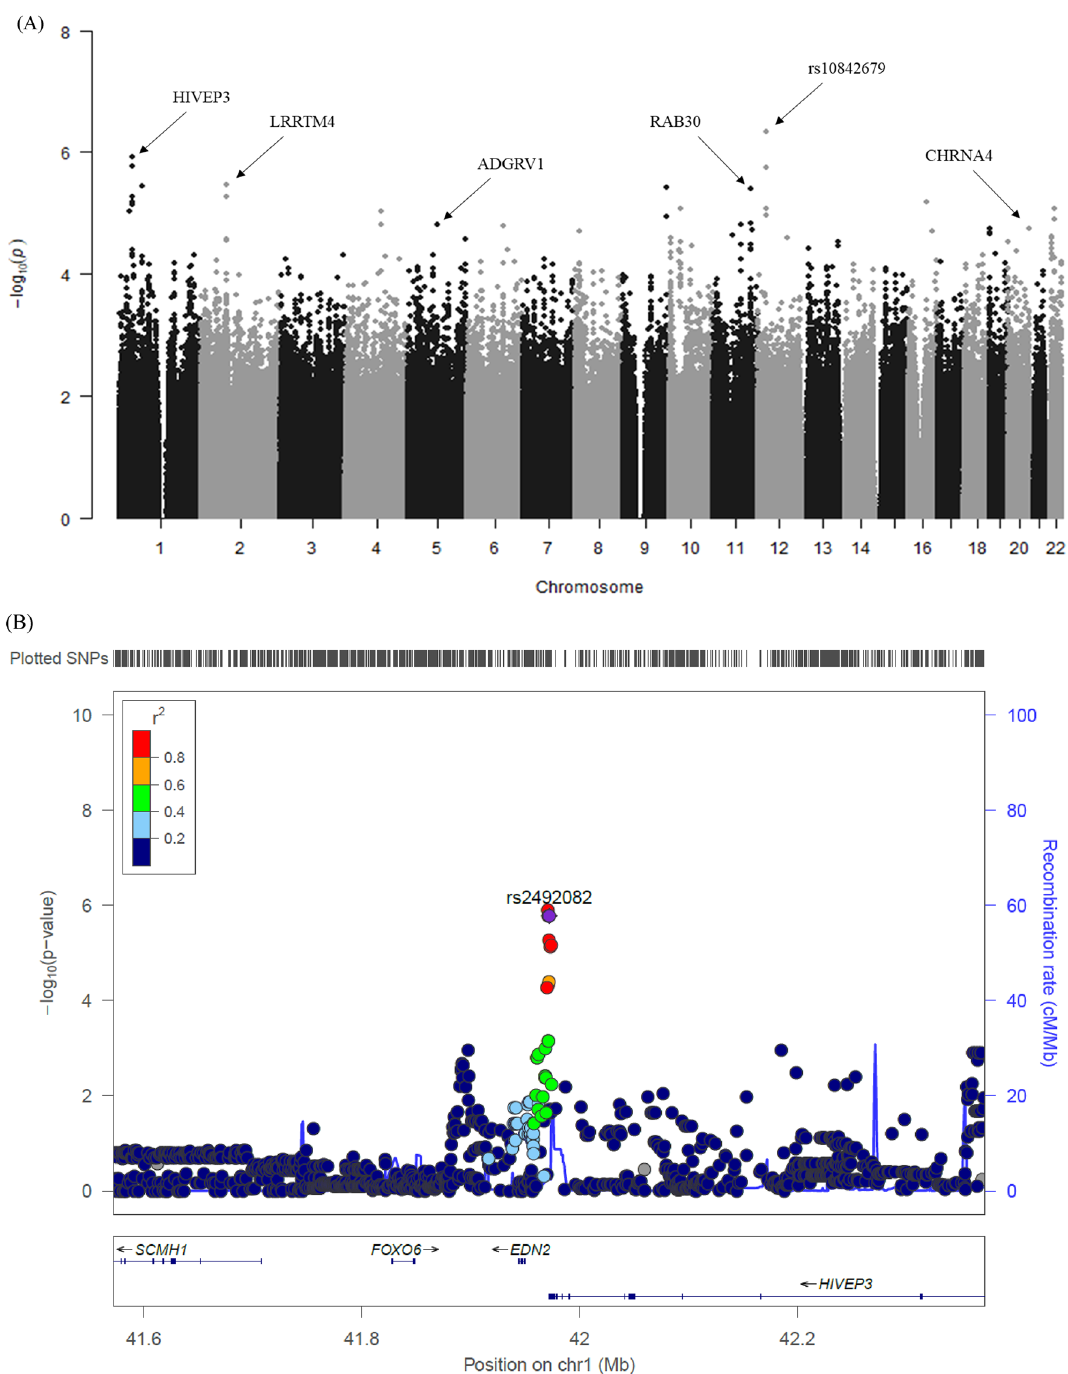
Figure 2. Manhattan plot and regional association plot. ( A ) P values from the genome-wide association study. The Manhattan plot shows the P values for the risk of neuroblastoma calculated using a logistic regression analysis. The X-axis represents the single-nucleotide polymorphism (SNP) markers on each chromosome. The highest P value ( P = 4.7E-07) was observed for rs10842679 on 12p.12.1. ( B ) Regional association plots at CNTN4 . Regional association plots containing both genotypes and SNPs within 400 kb of CNTN4 were generated by LocusZoom. The significance of the association (− log10-transformed P values) and recombination rate is plotted. SNPs are colored to reflect pairwise linkage disequilibrium ( r 2 ) with the most significantly associated genotyped SNPs in the 1000 Genomes Project Phase 1 interim release Asian (ASN) population genotypes. The most significant genotyped SNPs are labeled and shown in